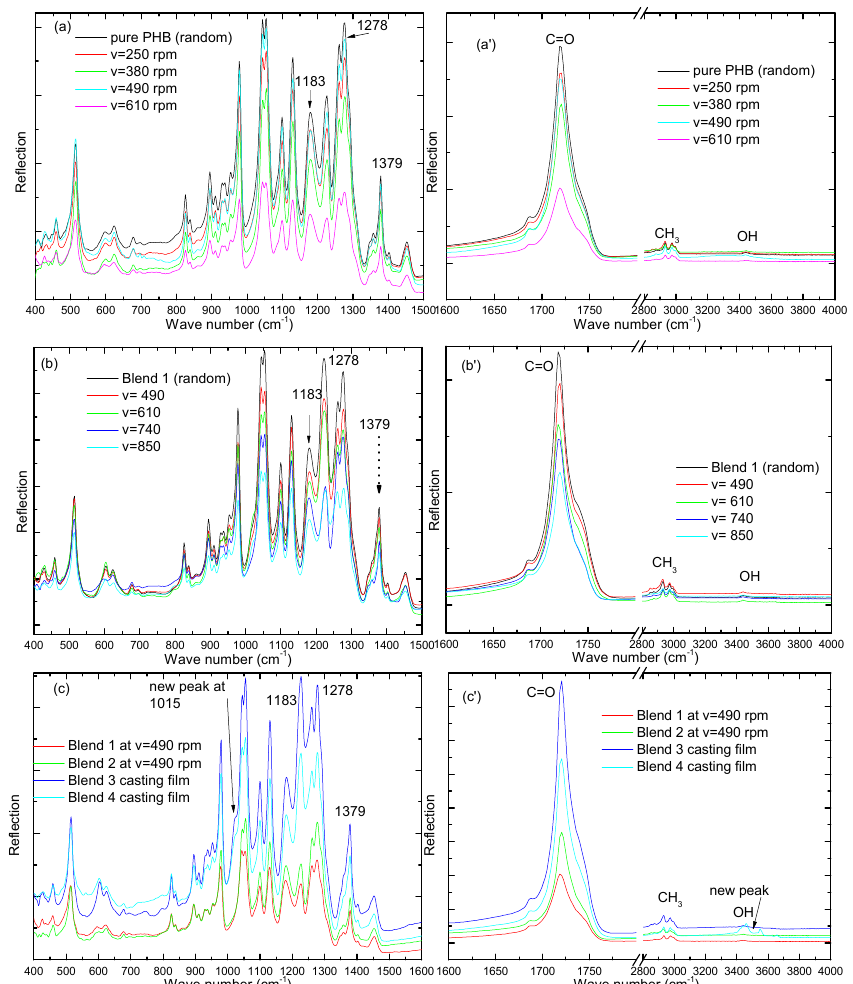
Figure 9. FT-IR spectrum of electrospun PHB and their blends in the infrared spectrum regions at different take-up speeds ( a ) from 400 to 1600 cm − 1 of PHB and ( a' ) from 1600 to 4000 cm − 1 of PHB; ( b ) from 400 to 1600 cm − 1 of blend 10; and ( b' ) from 1600 to 4000 cm − 1 of blend 10; ( c ) from 400 to 1600 cm − 1 of blends 10, 14, 16, 17, and ( c' ) from 1600 to 4000 cm − 1 of pure PHB and blends 1 and 2, at constant take-up speeds of 490 rpm, but blends 3 and 4 as a casting film.